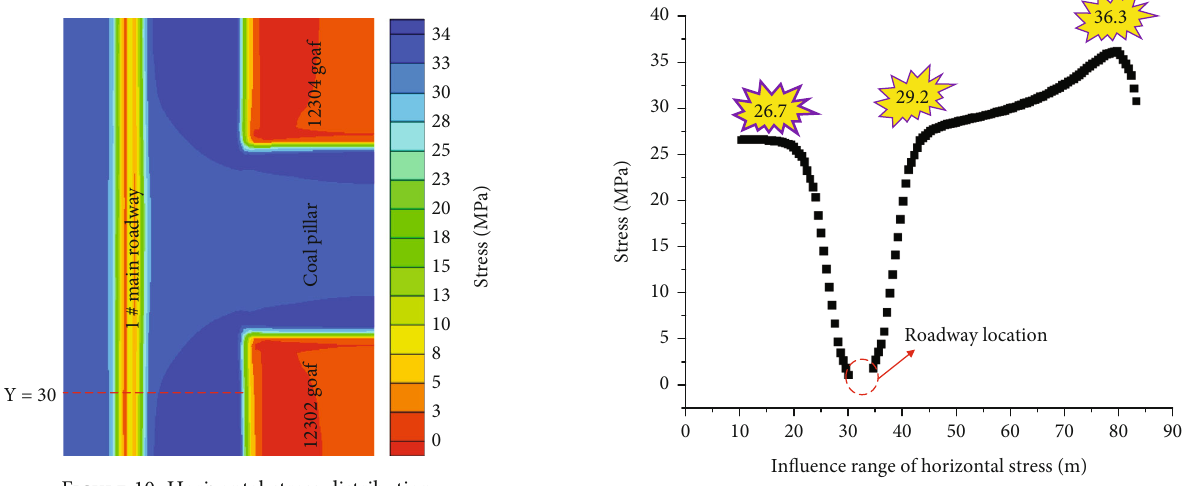
Figure 11: Horizontal stress curve at Y = 30 .